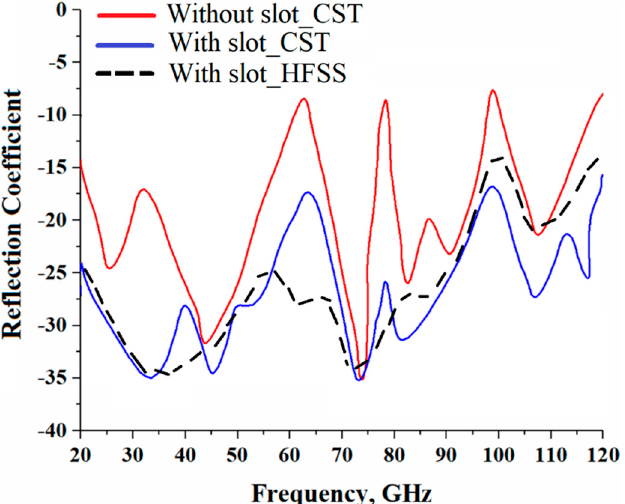
Figure 2. Reflection-coefficient (S 11 < − 10 dB) response of the microstrip antenna array “without” slots and “with” slots using two different commercially available 3D full wave electromagnetics simulation tools (CST Microwave Studio ® and HFSS™).